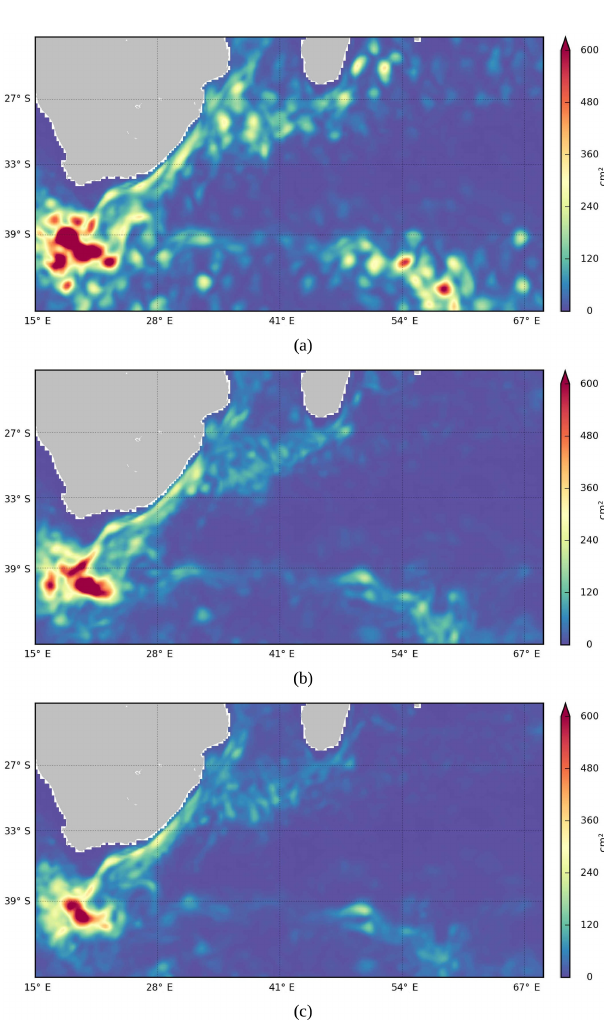
Figure 6. AC 7-day forecast MSE of SL in cm 2 for Sat1 (a) , Sat2 (b) and Sat3 (c) . Figure 7. AC analyses MSE of SL in cm